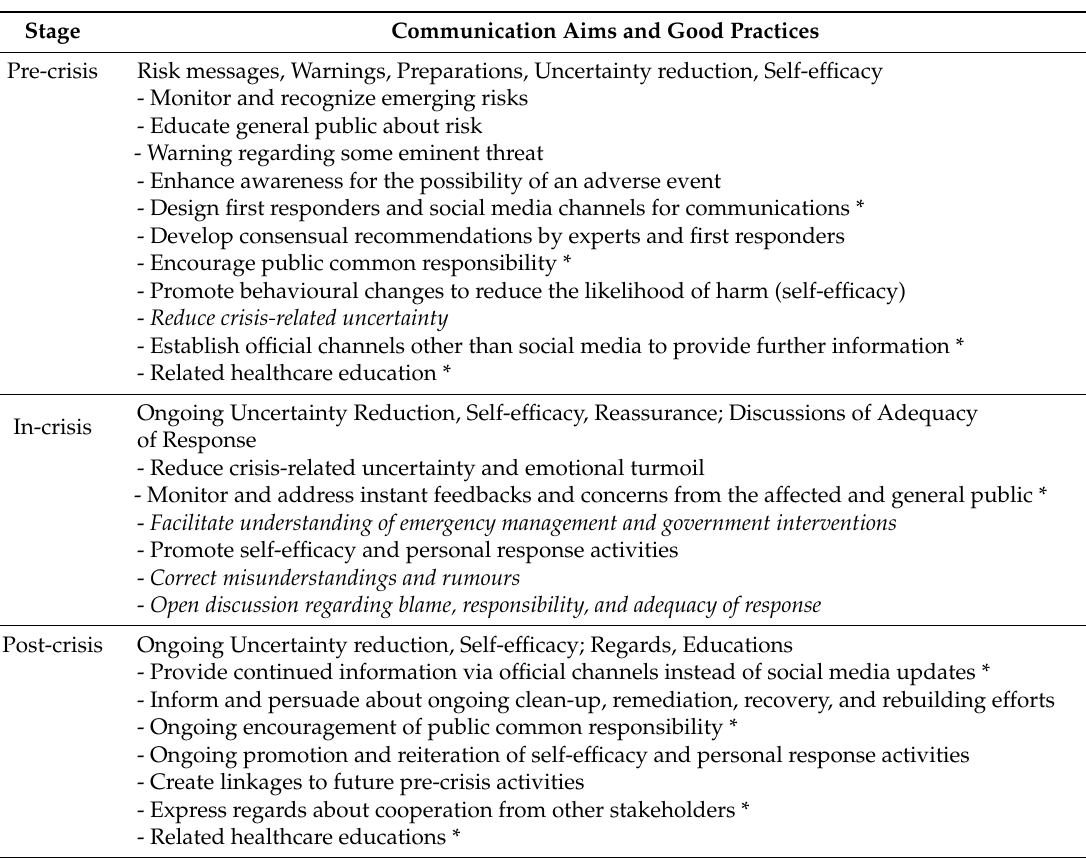
Table 6. The adapted Crisis and Emergency Risk Communication Model (CERC) model in social media contexts based on current